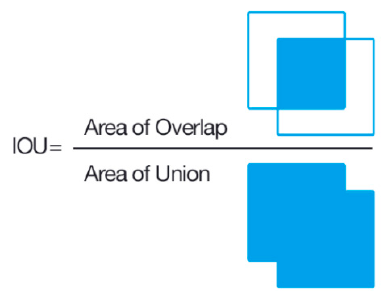
Figure 7. Visual representation of intersection over union (IOU), which is a metric used for measuring object detection performance.